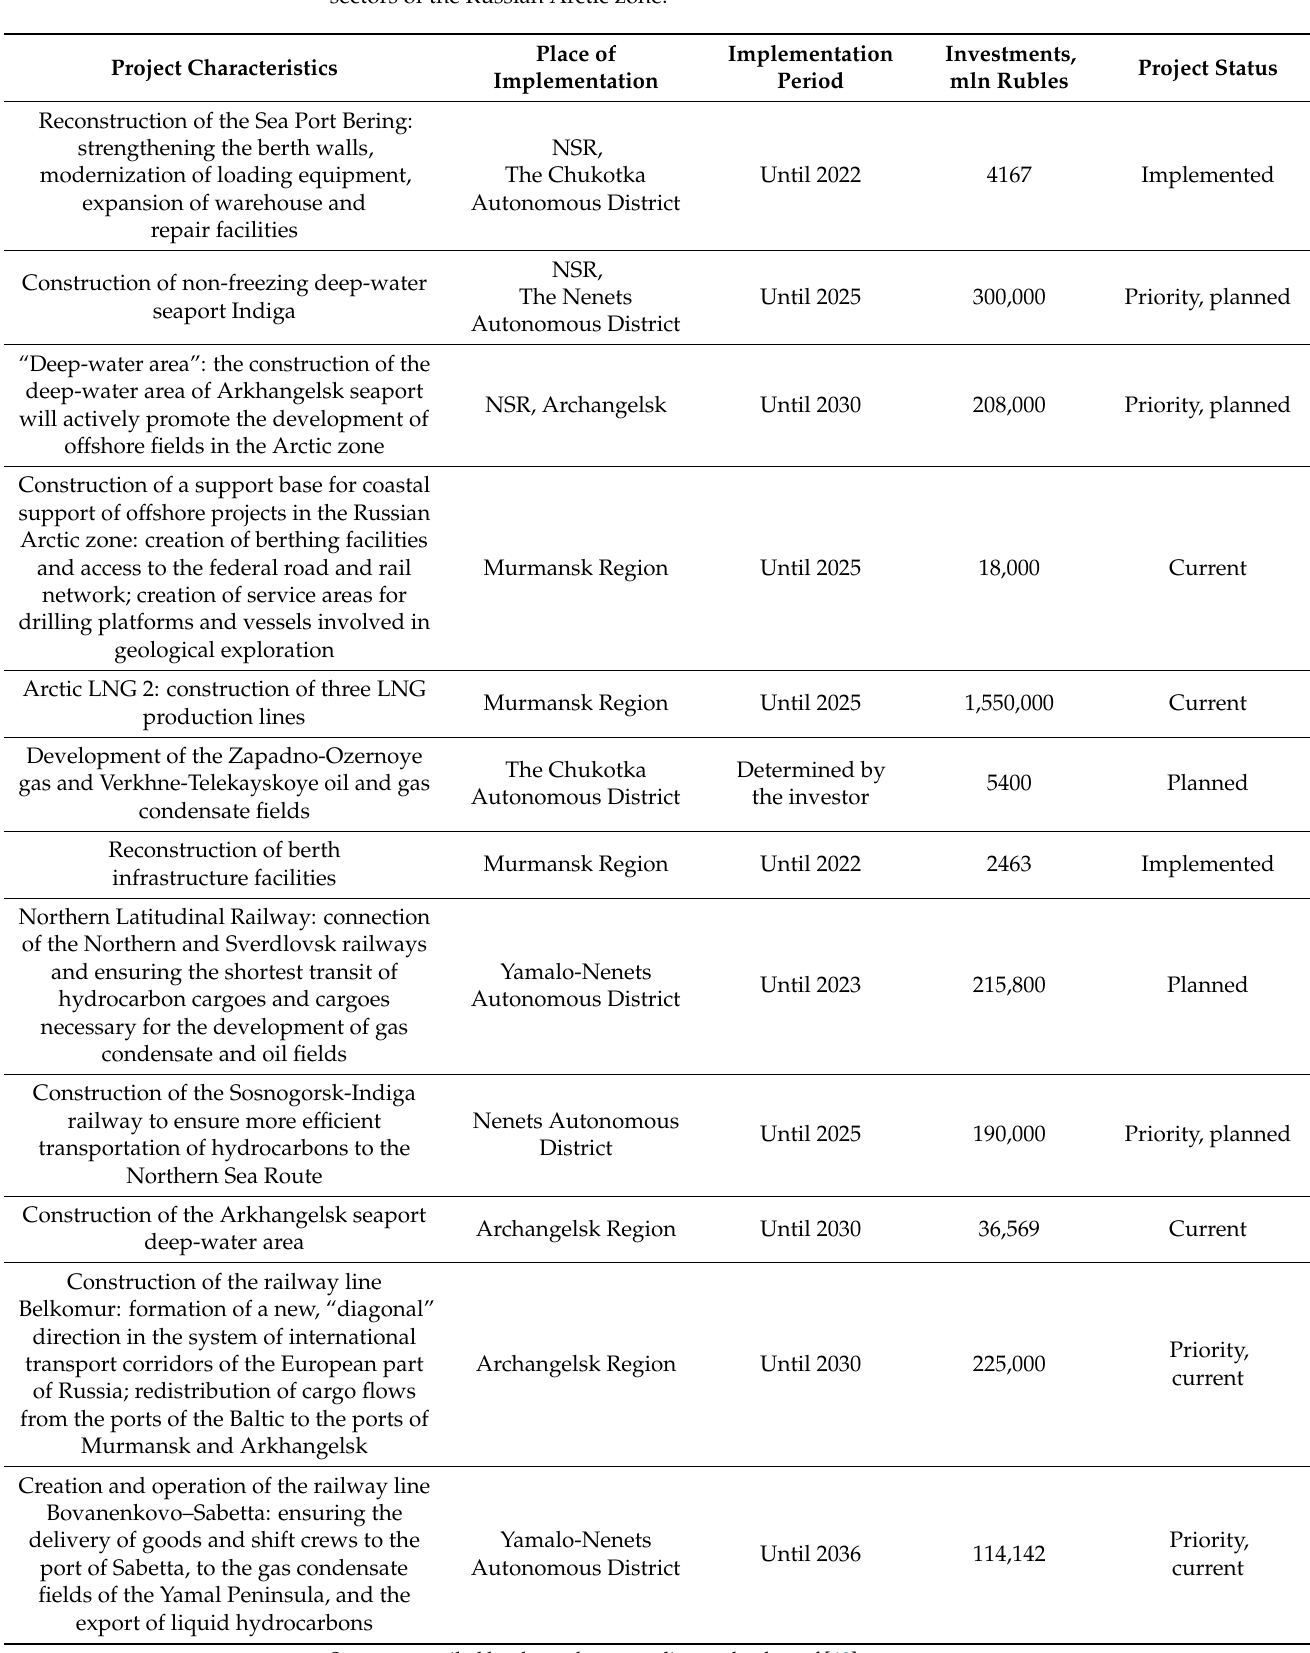
Table 4. The main investment projects implemented for the development of transport and oil and gas sectors of the Russian Arctic